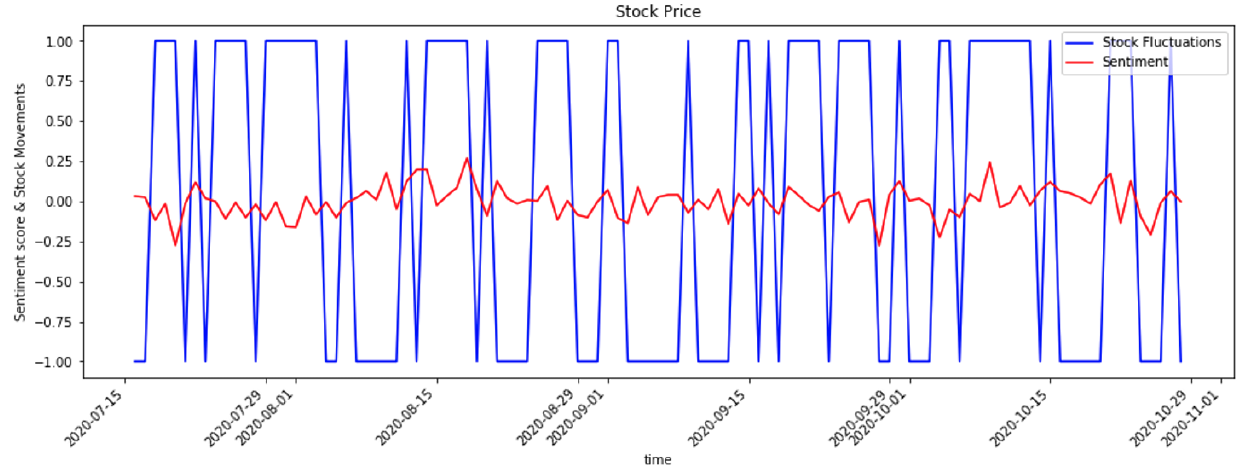
Figure 7. Sentiment & Stock Change for ‘Twitter with TextBlob’ data set.